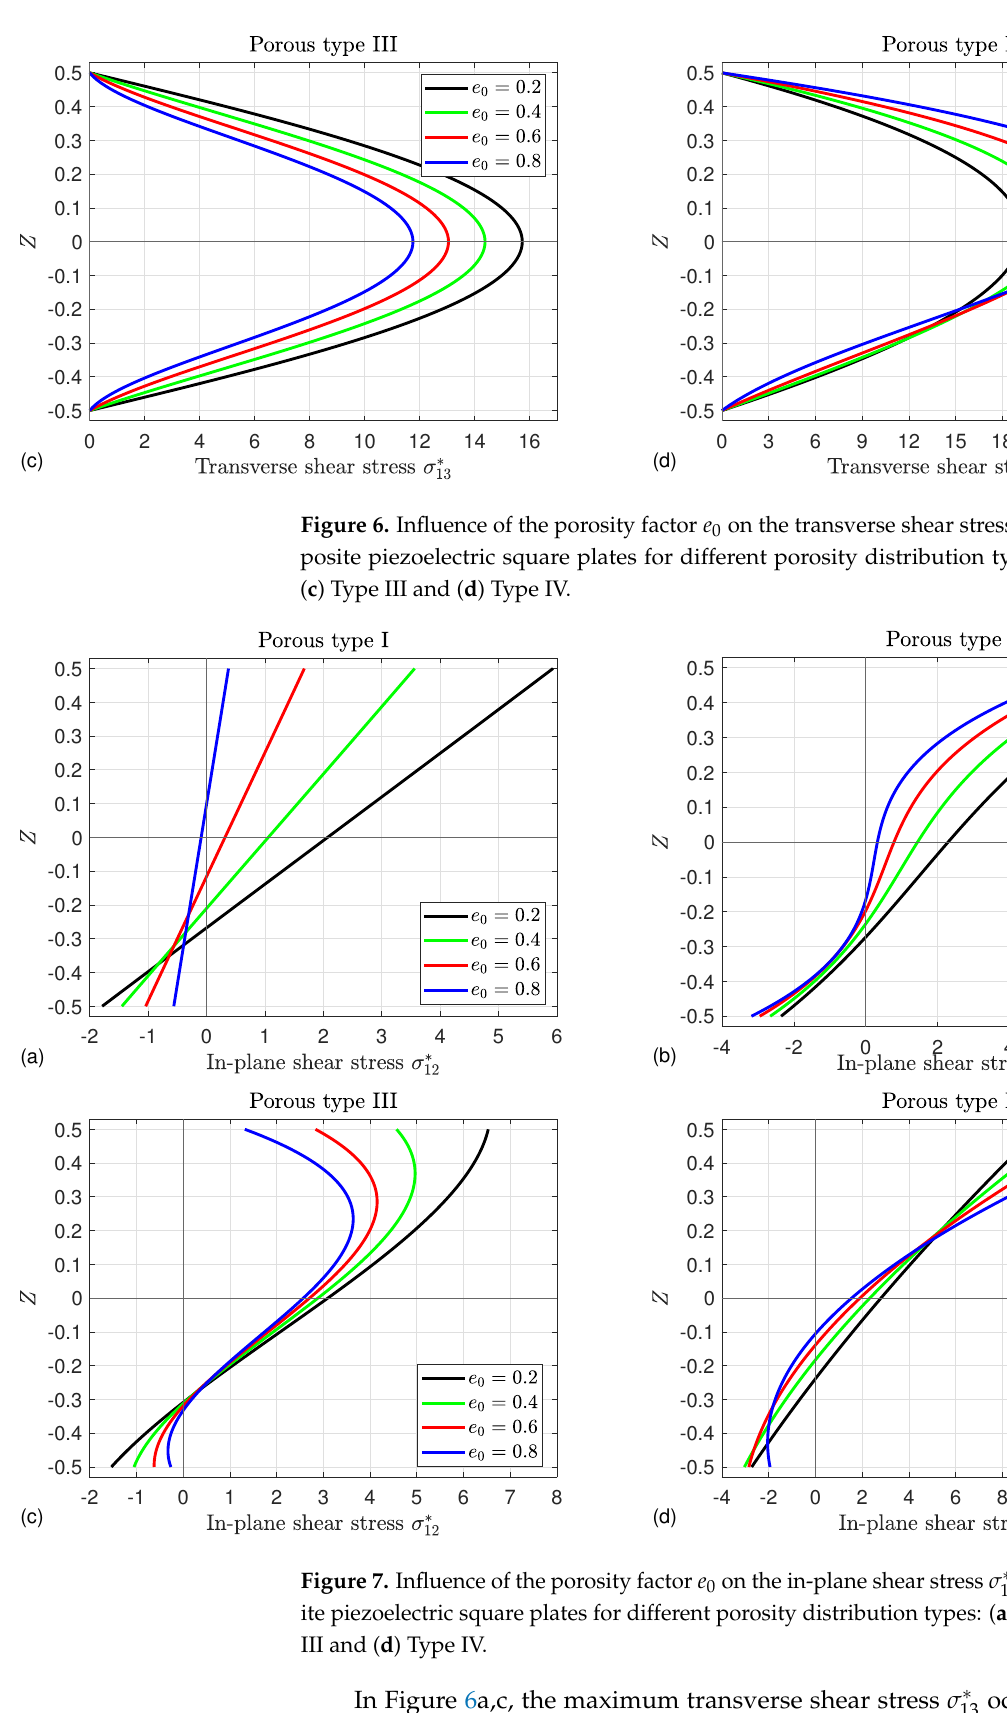
in FG porous nanocompos- 12